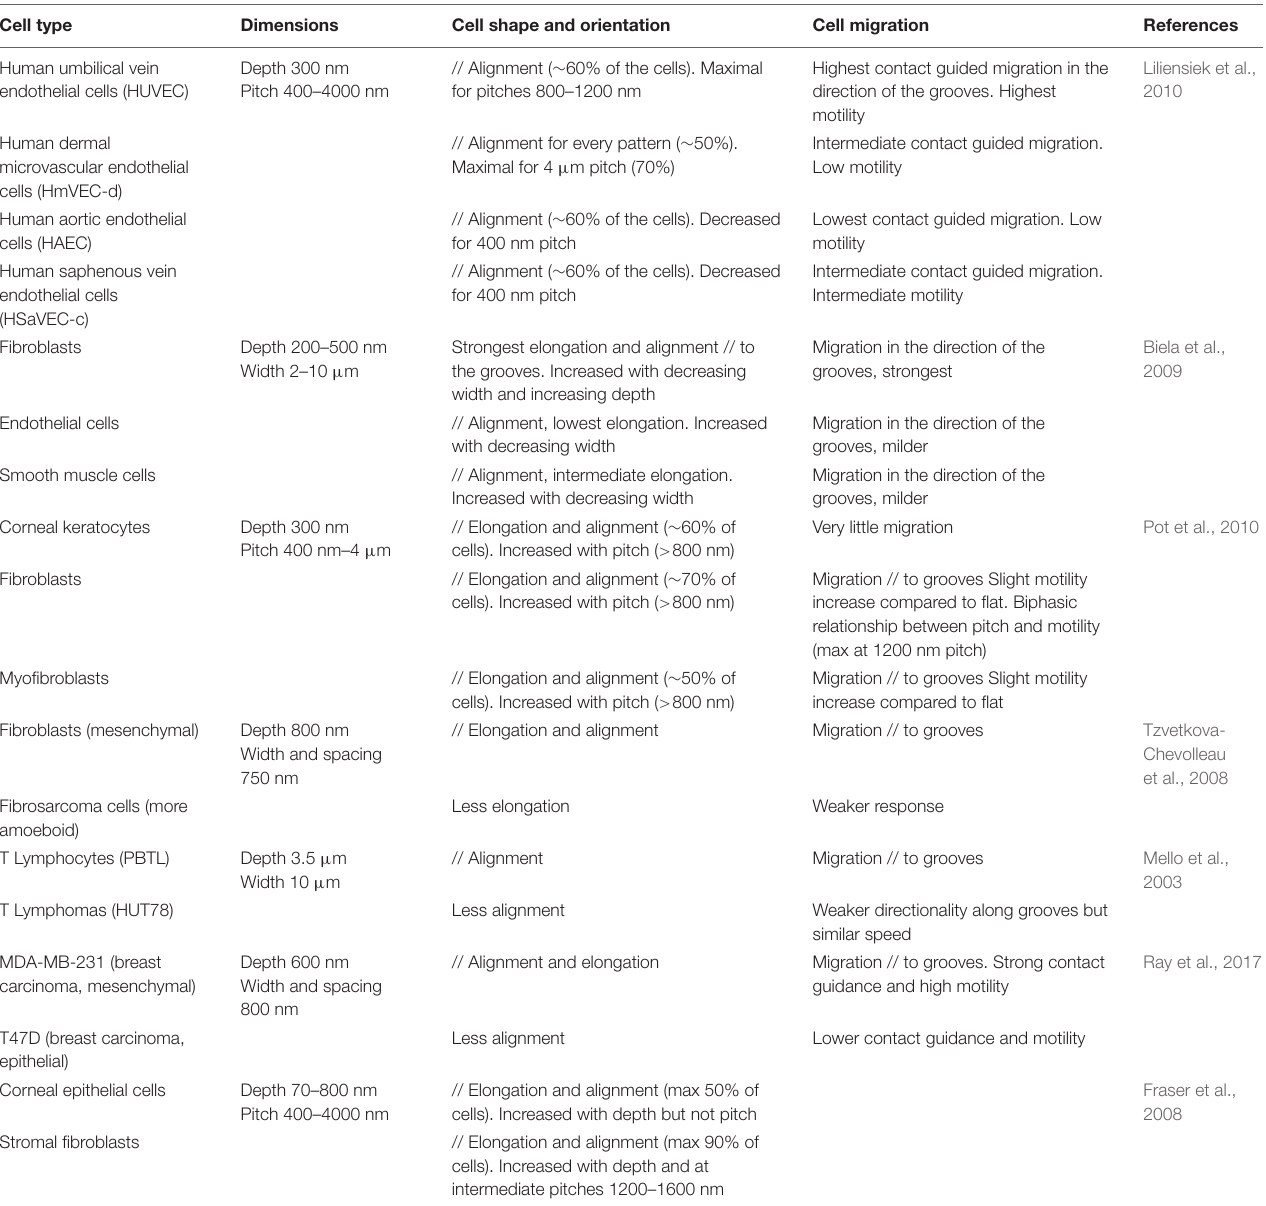
TABLE 3 | Cell type specific responses to grooved